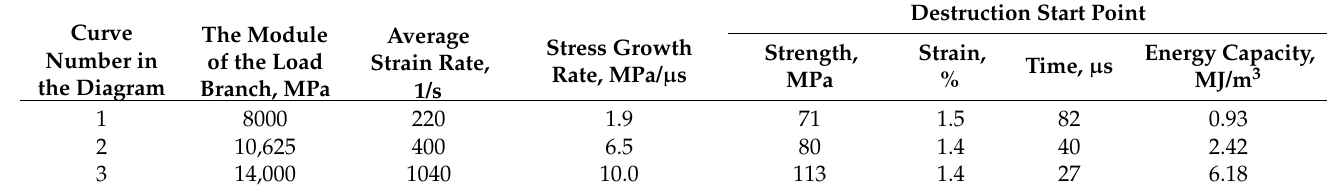
Figure 7. Definition of modules of load branches.